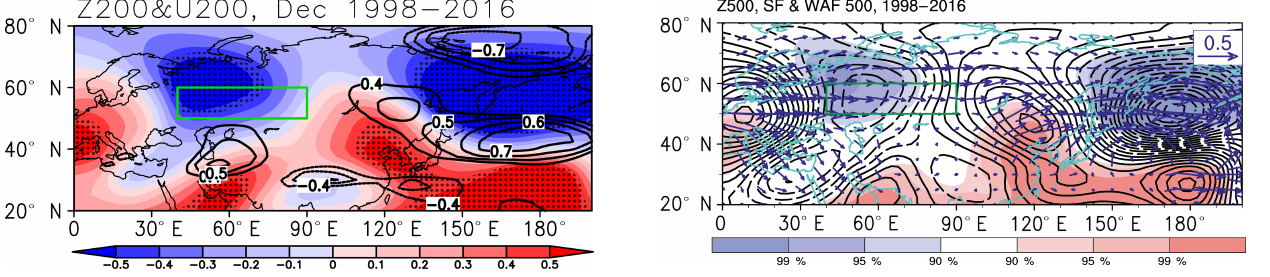
Figure 3. The CC between the SC ES and Z200 (shading) and U200 (contour) in December from 1998 to 2016. The black dots indicate the CC exceeded the 95% confidence level ( t test). The green box represents the ES area. The linear trend is removed.